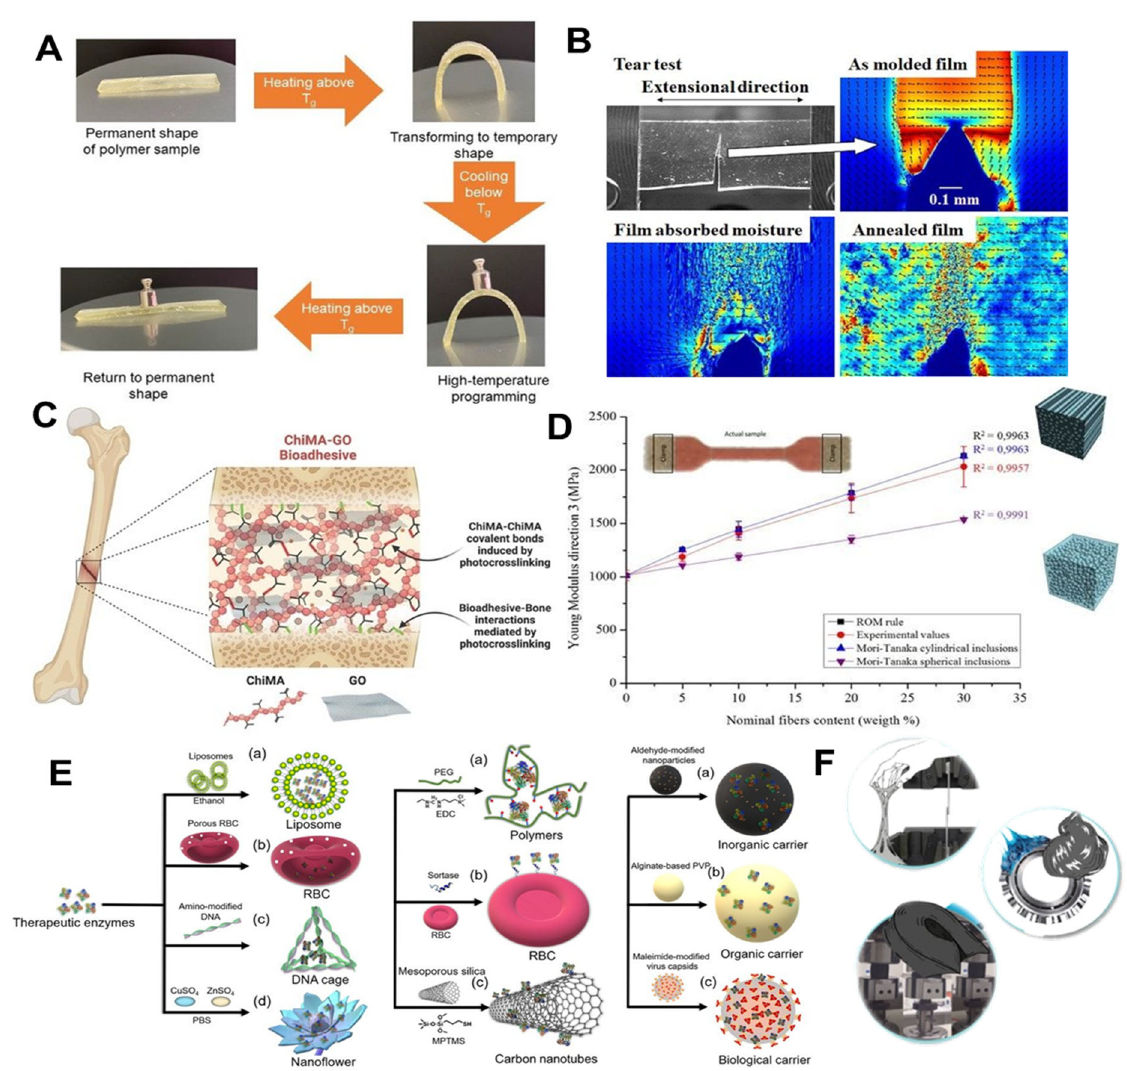
Figure 1. ( A ) Scheme of shape ‐ memory characteristics of the bio ‐ based polymers developed by Jaras et al. [1]. ( B ) Images of the in situ retardation measurements at the tip of the tear for the polylactic acid ‐ based film developed in Yutaka et al. [2]. ( C ) Schematic overview of the bioadhesive formulation and application in Céspedes ‐ Valenzuela et al. [3]. ( D ) Overview of the tensile properties of the green composites developed by Lemaire et al. [4]. ( E ) Different therapeutic enzymes studied in Zhu et al. [5]. ( F ) Adhesives, lubricating greases and elastomers as biomaterials studied in Borrero ‐ López et al. [6].